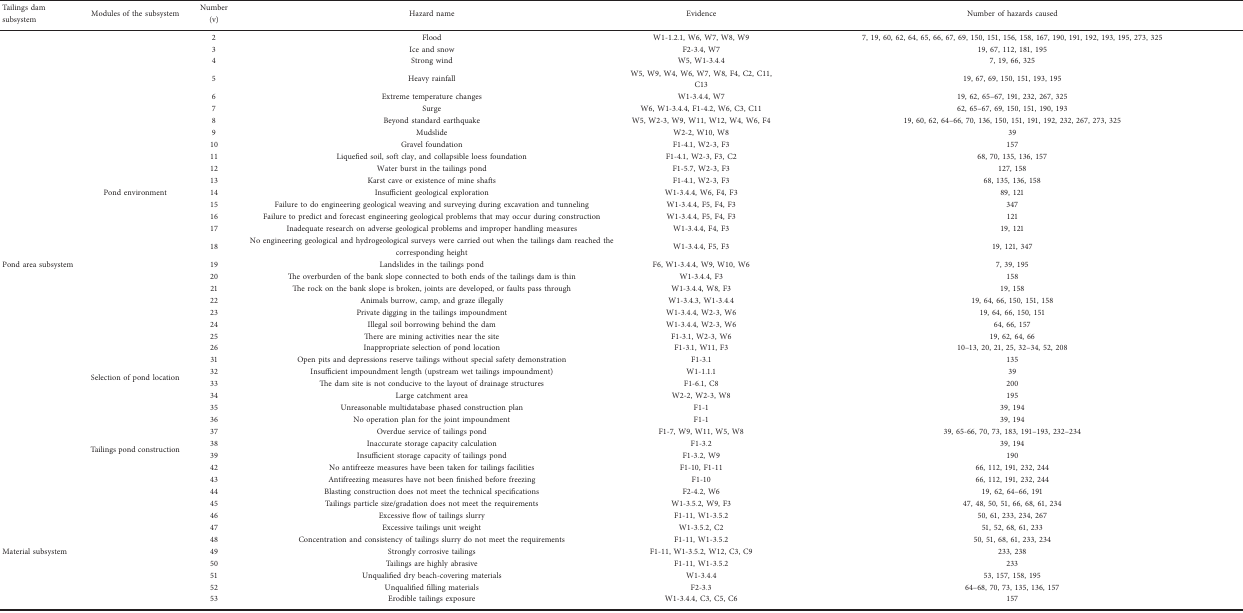
Table 1: List of seepage hazards in tailings pond.